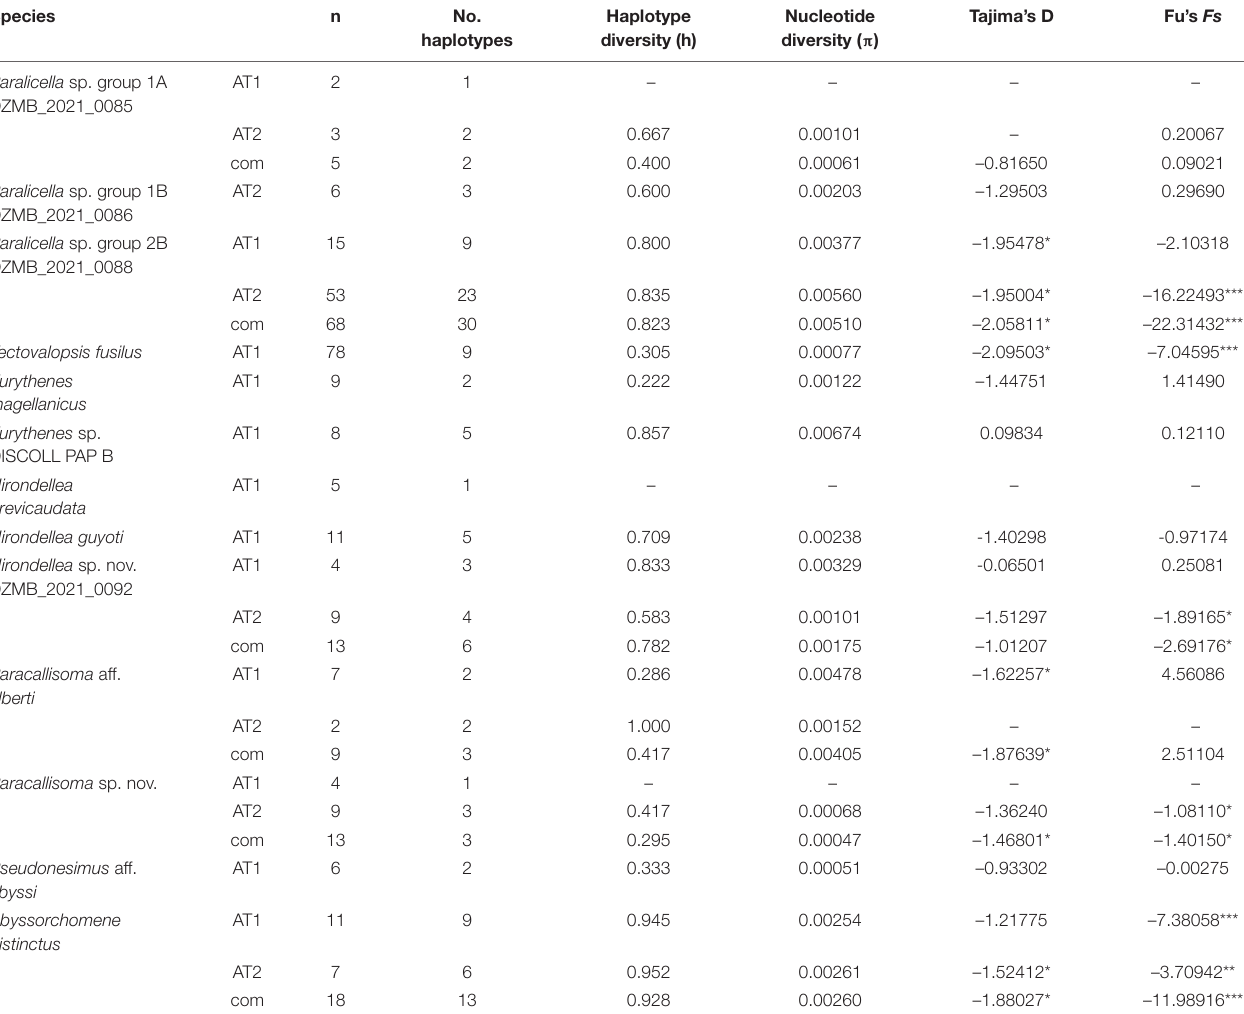
TABLE 4 | Genetic diversity indices, parameters of demographic history and neutrality and population expansion tests calculated for the COI dataset.